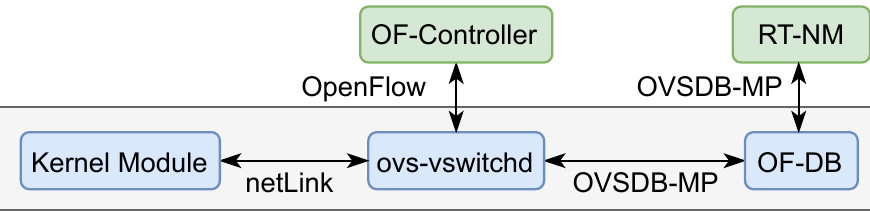
Figure 4. Network configuration process.